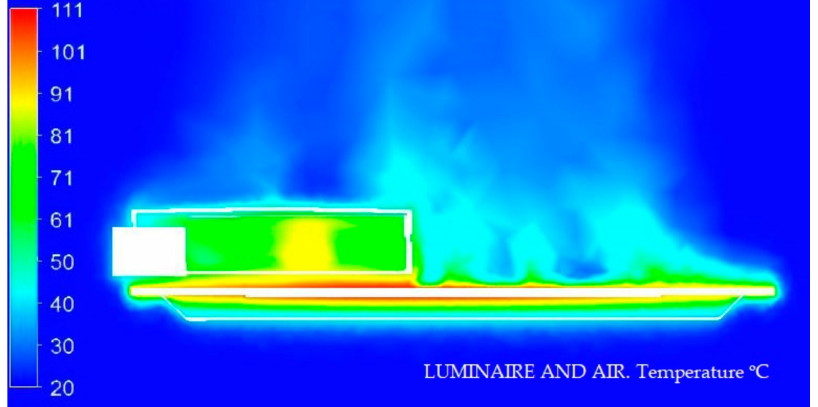
Figure 8. Temperature medium section of the luminaire at 20 ◦ C. Source: HyperView